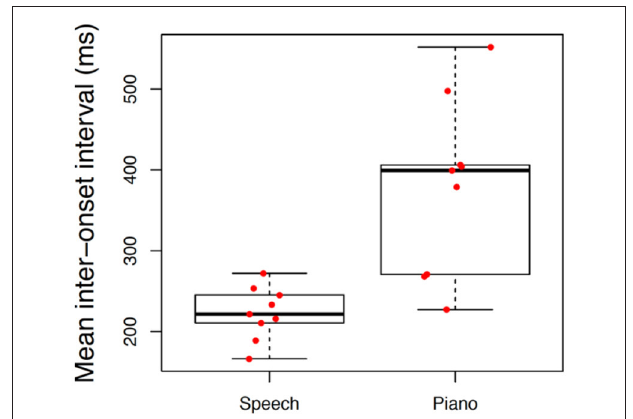
FIGURE 7 | Boxplot illustrating differences in spontaneous rate across conditions. Individual boxplots represent the inter-quartile range (rectangle), median (dark horizontal line), and extreme scores (whiskers). Individual participant means are superimposed on box plots with random jitter along the x-axis to avoid occlusion of data points.